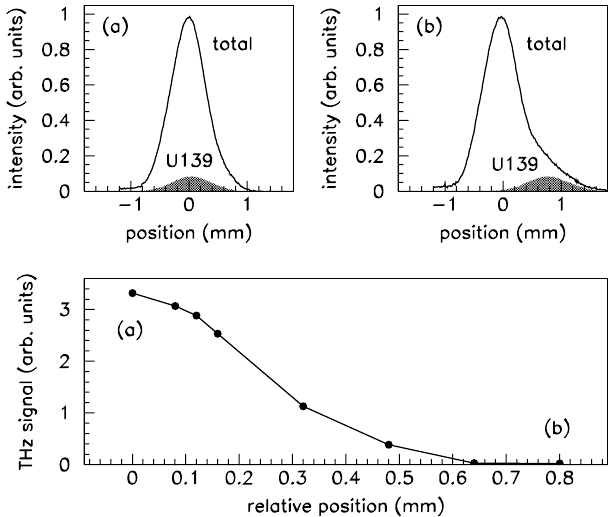
FIG. 4. Horizontal profile of synchrotron radiation from the U139 modulator with and without laser pulses as observed with a CCD camera (a) at optimum overlap and (b) displaced by 0.8 mm. The bottom part of the figure shows the THz radiation intensity as a function of the displacement.